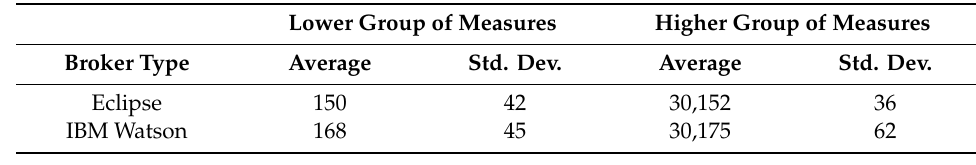
Table 2. Statistics of the D CD (Delay from Cloud user application to Database) collected in the experiments. All values are in milliseconds.